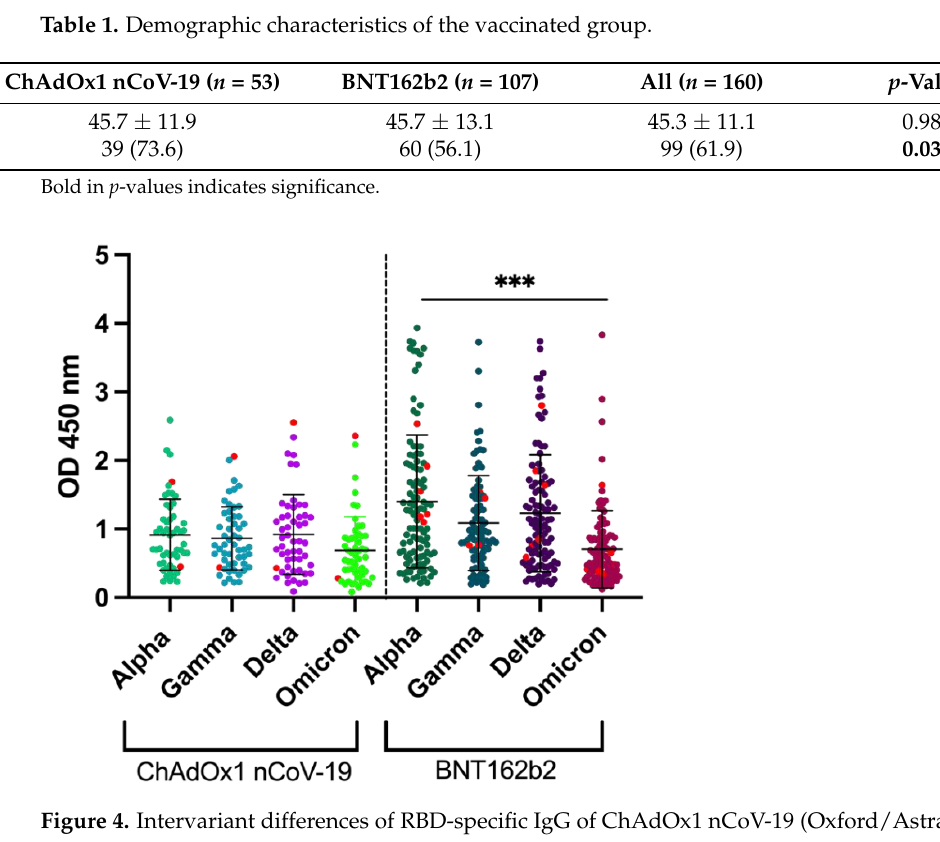
Figure 3. Age distribution of vaccinees and anti-RBD IgG levels against SARS-CoV-2 variants. ( A ) Age distribution of participants receiving ChAdOx1 nCoV-19 (Oxford/AstraZeneca) or BNT162b2 (Pfizer); ( B ) Anti-RBD-domain IgG levels detected against the variants Alpha, Gamma, Delta, and